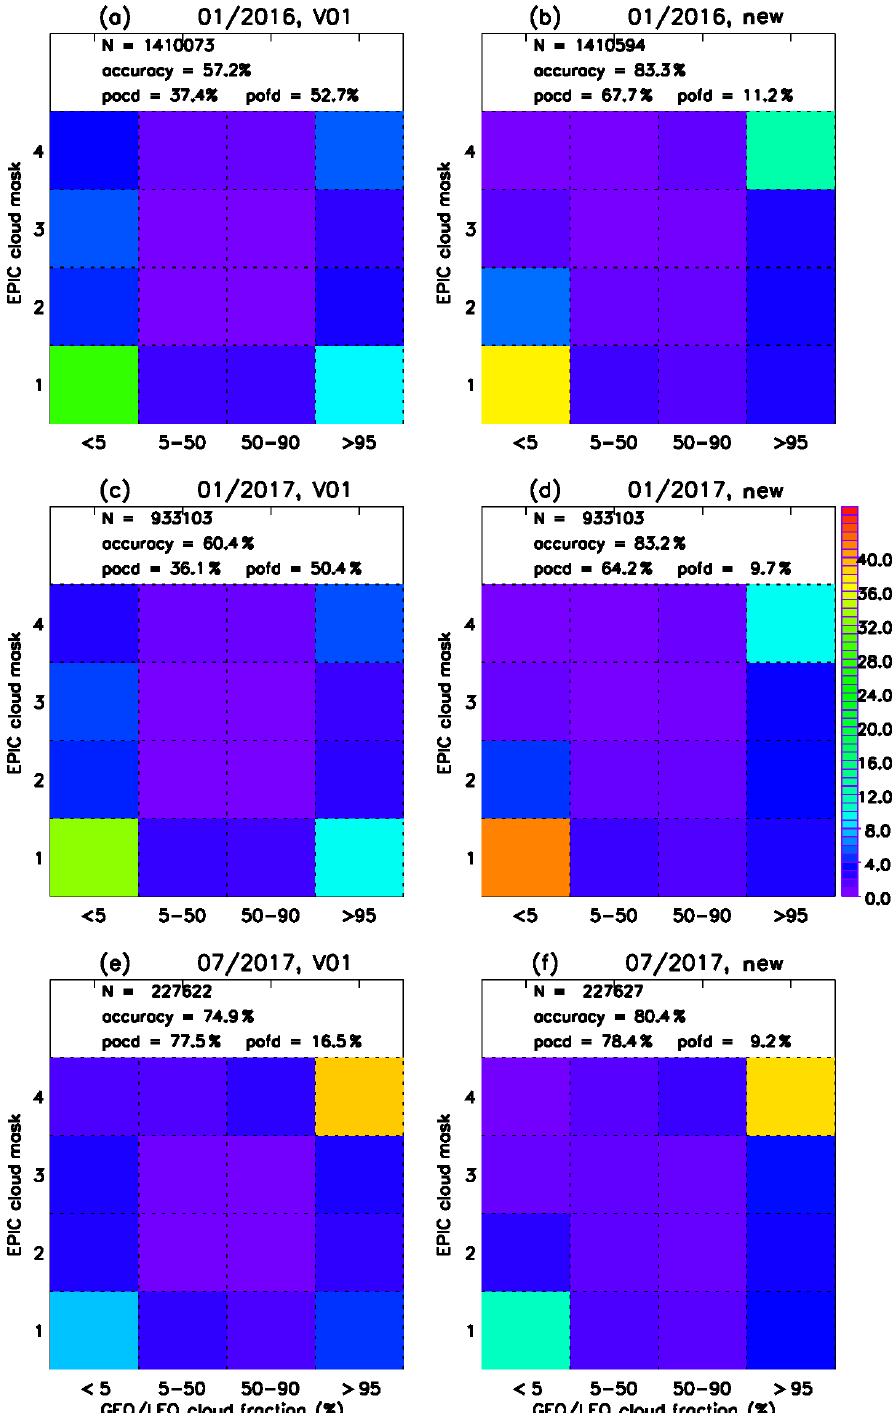
Figure 7. Percentage of pixels in each pixel-by-pixel matchup category between cloud mask from EPIC and GEO/LEO composite cloud fraction over snow and ice surfaces for January 2016 (a, b) , January 2017 (c, d) , and July 2017 (e, f) . Panels (a, c, e) are from the current EPIC cloud mask algorithm, and panels (b, d, f) are from the new algorithm. The diagonal squares represent agreement between the GEO/LEO and EPIC cloud mask, while the off-diagonal squares represent disagreement between the two products. The number of samples, accuracy, probability of correct detection (POCD), and probability of false detection (POFD) are shown in the white area on top of each